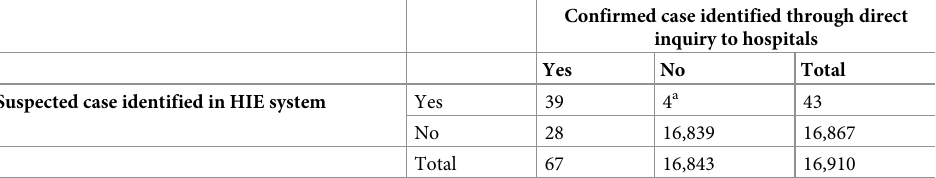
Table 1. Microcephaly cases born to NYC resident mothers and diagnosed at ages 0–2 days at three birth hospi- tals—New York City, January 1, 2013 –December 31,